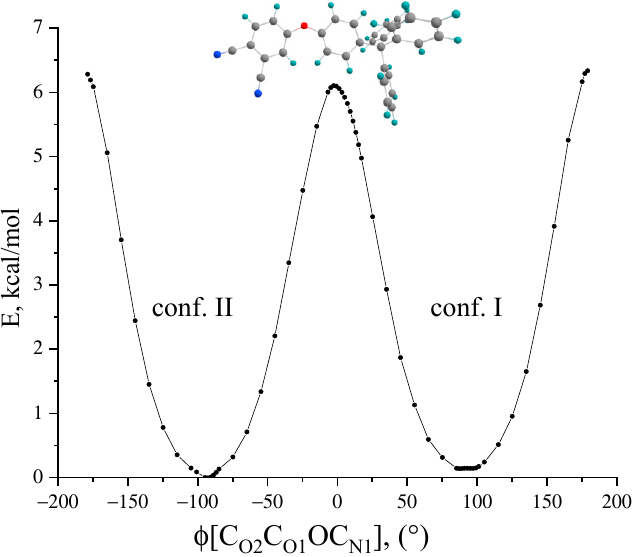
Figure 2. Conformers and transition states of the TPPN molecule. Projections with the same orienta- tion of the trityl fragment are shown.